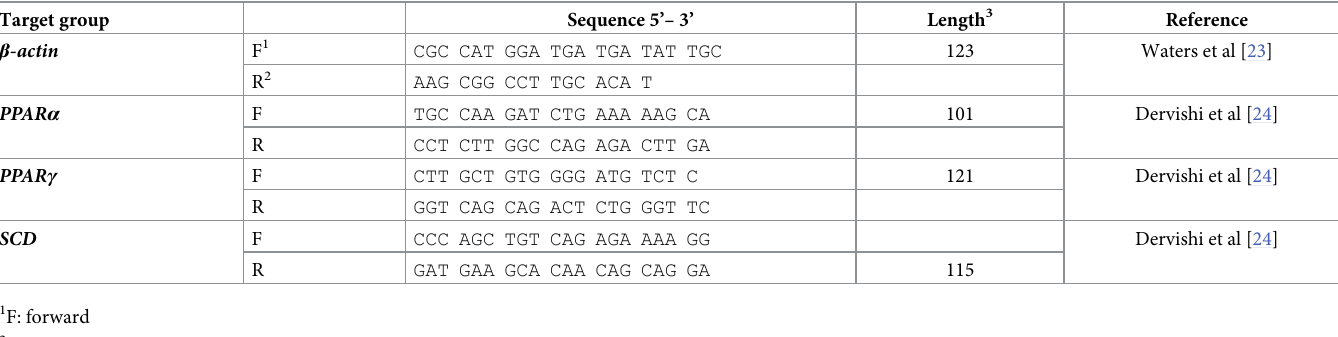
Table 3. Names and sequences of the primers used for gene expression study. Target